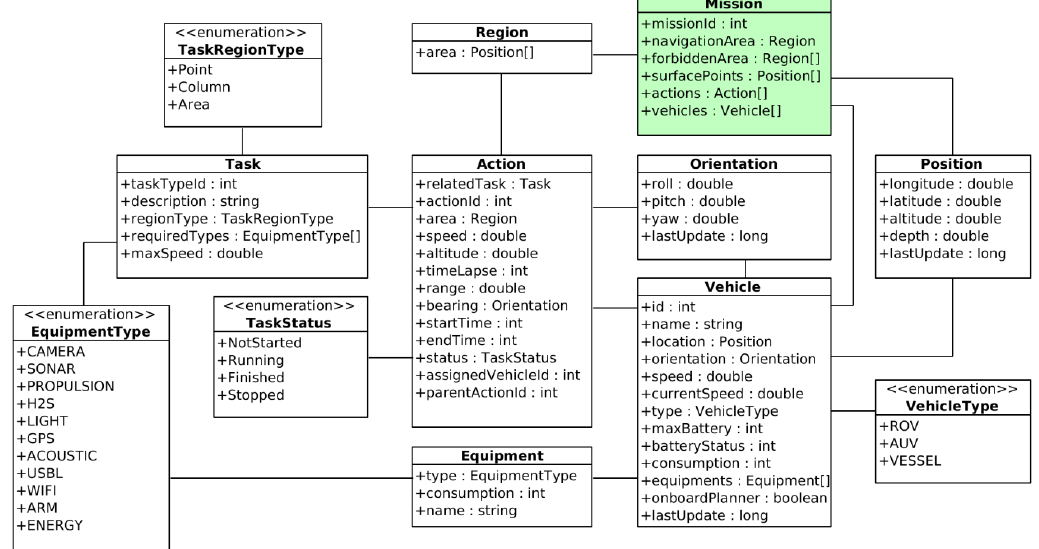
Figure 2. The SWARMs mission and planning ontology.